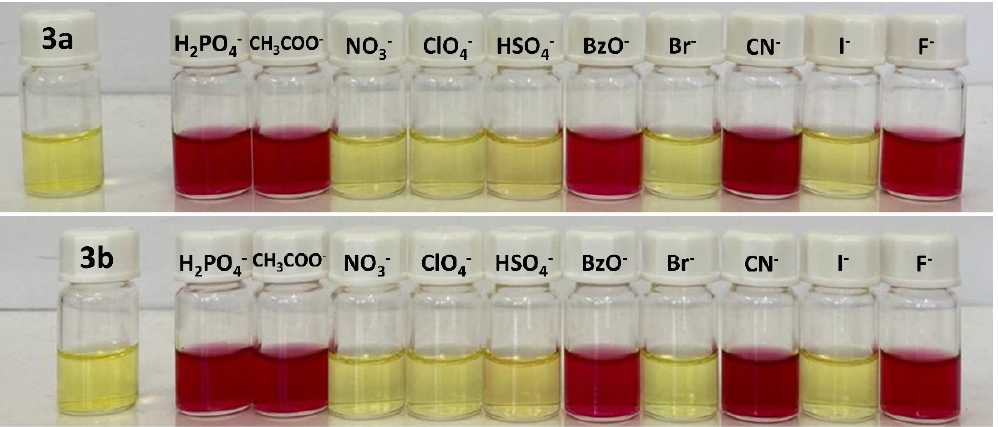
Figure 1. Preliminary chemosensory tests of compounds 3a – b upon interaction with different ani-